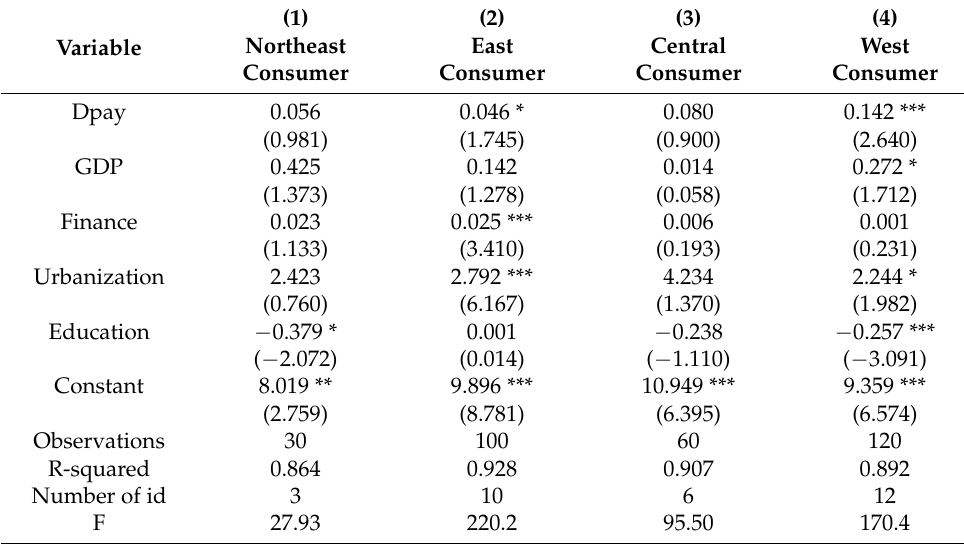
Table 12. Regional heterogeneity